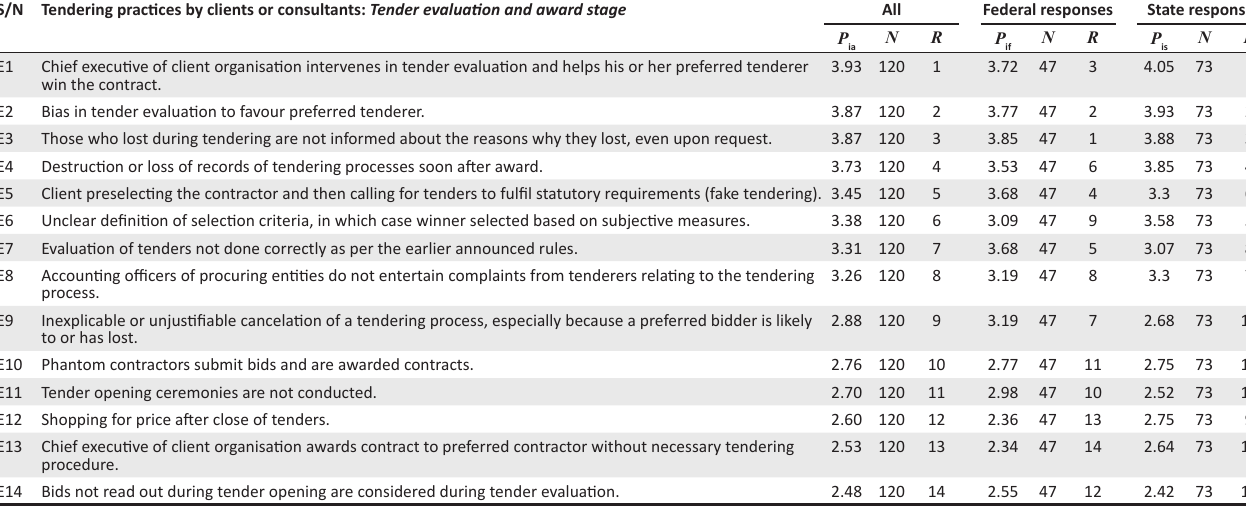
TABLE 5: Responses on the unethical tendering practices of clients or consultants at the tender evaluation and award stage. S/N Tendering practices by clients or consultants: Tender evaluation and award stage All